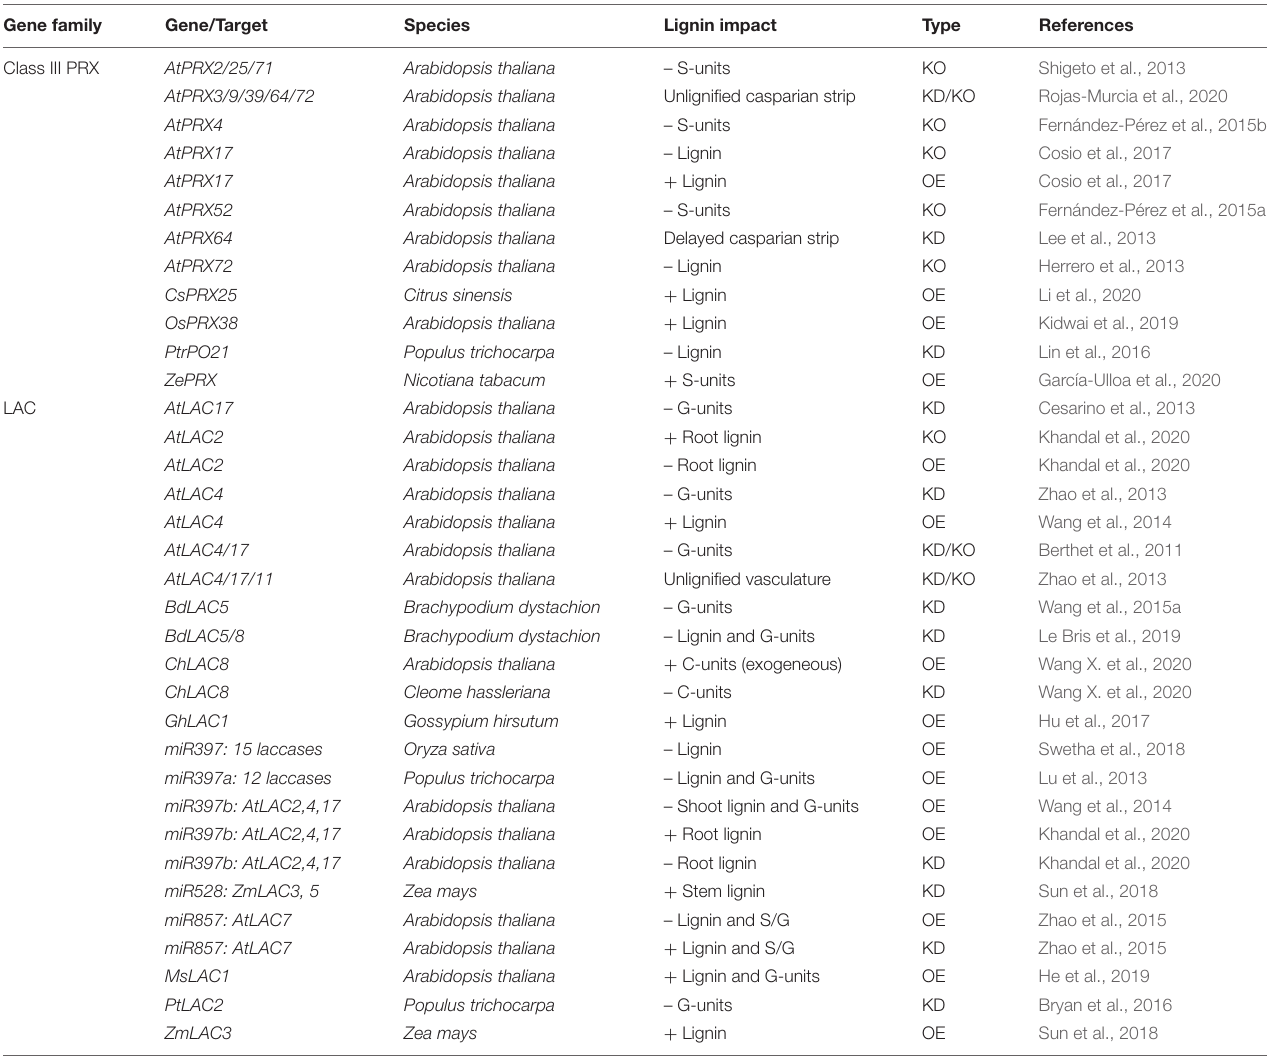
TABLE 2 | Reported impact of phenoloxidase knock-out (KO), knock-down (KD), and over-expression (OE) on lignin amount and composition. Gene